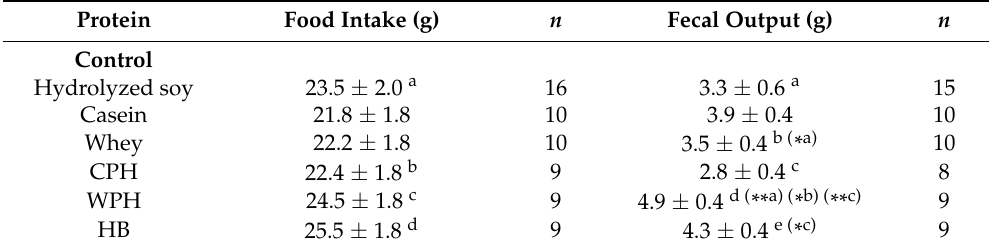
Table 1. Animal food intake and fecal